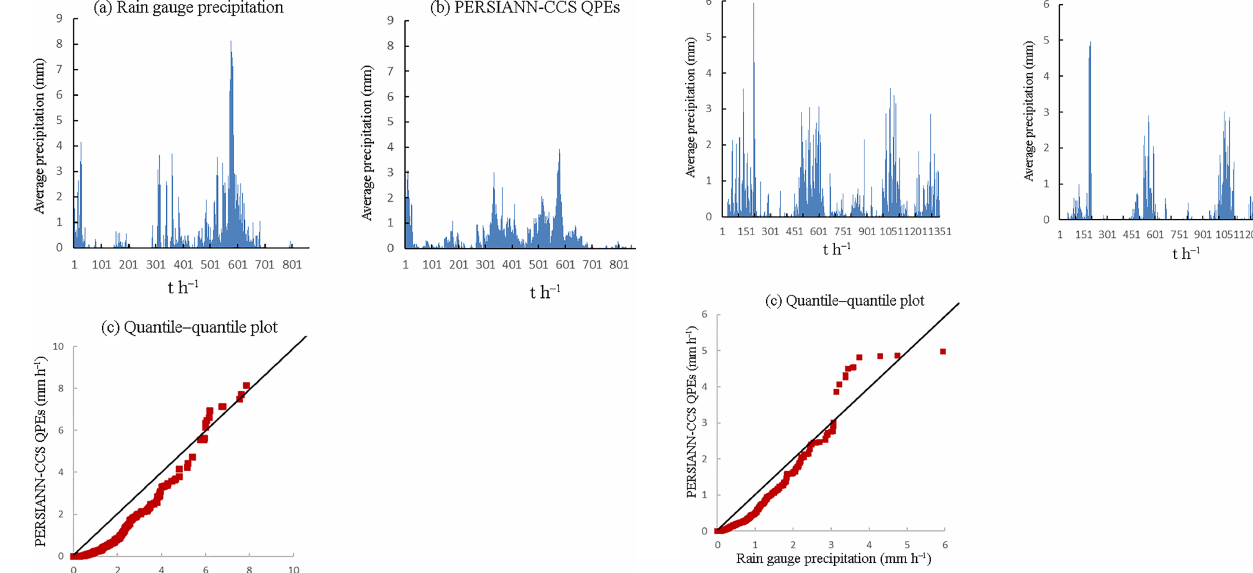
Figure 7. Precipitation pattern comparison of two precipitation products (2012): (a) is the average precipitation of rain gauges, (b) is the average precipitation of PERSIANN-CCS QPEs, and (c) is the quantile–quantile plot, in which the 45 ◦ line is used to compare the two precipitation